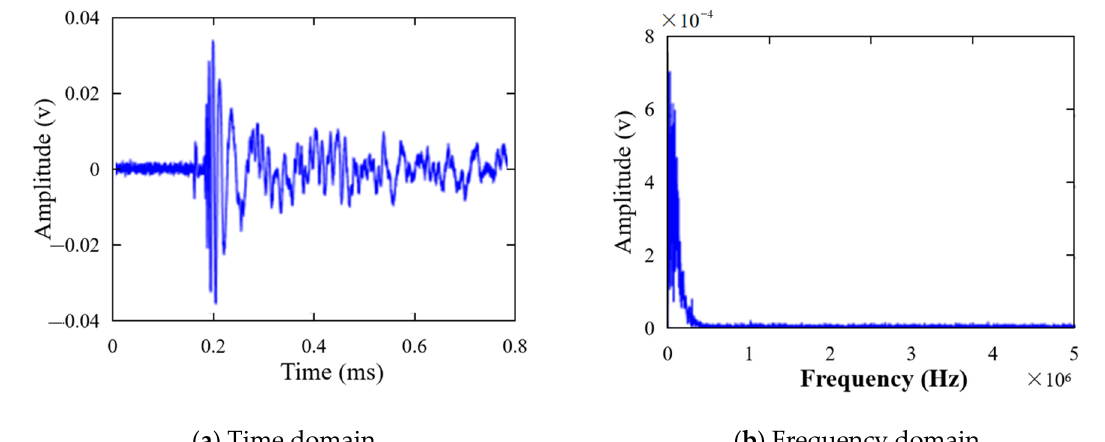
Figure 17. The original broadband signal excited by pulse laser.